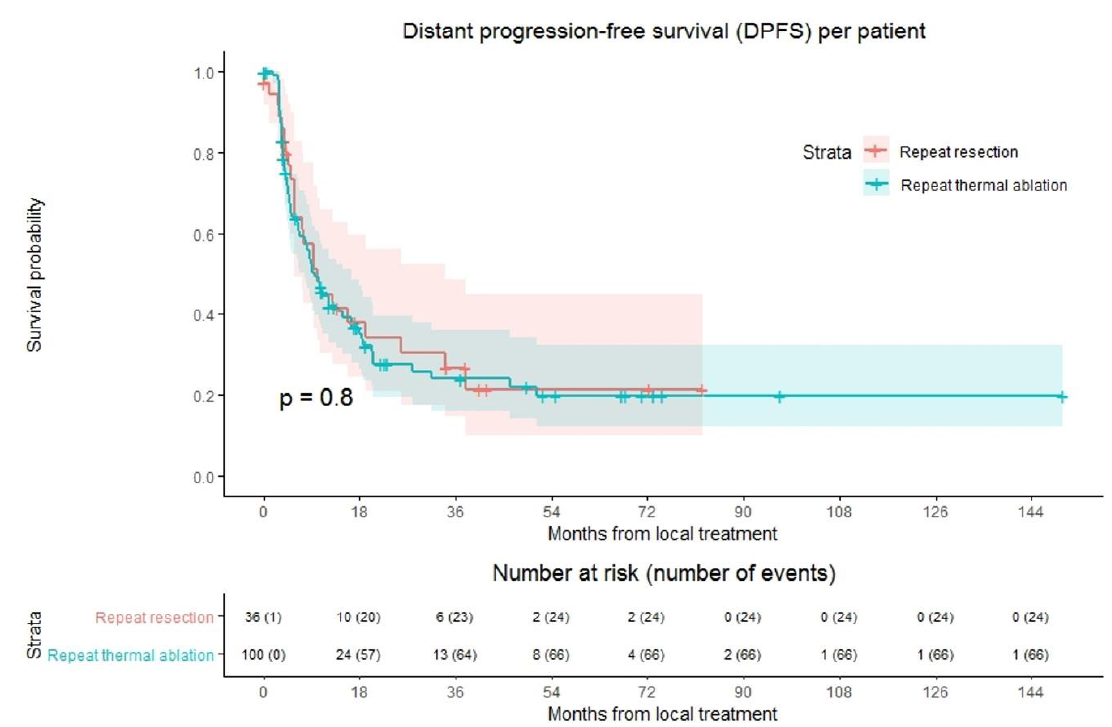
Figure 3. Kaplan–Meier curves of distant progression-free survival (DPFS) per patient after repeat resection (red) and repeat thermal ablation (green). Numbers at risk (number of events) are per patient. Overall comparison log-rank (Mantel-Cox) test, p = 0.803. Death without distant progression (competing risk) is censored.